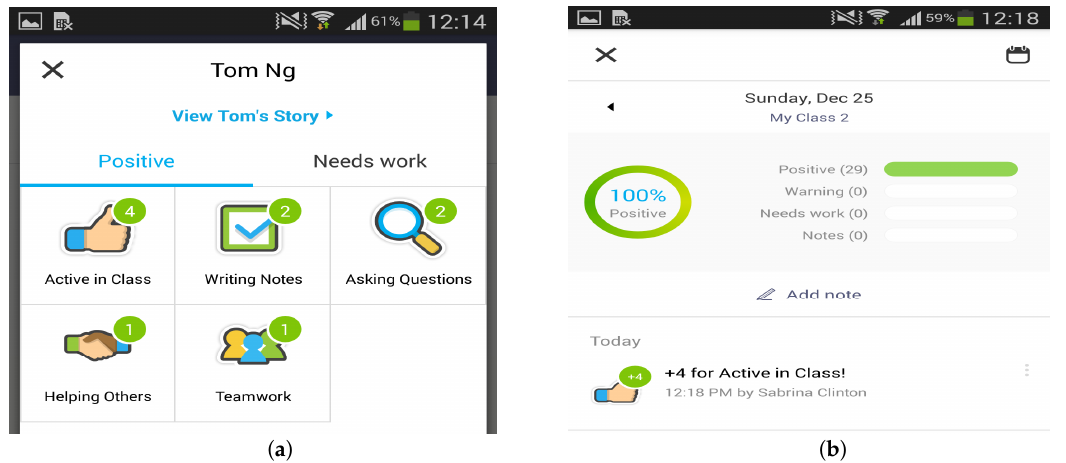
Figure 7. Incentive mechanism of the class engagement analysis (CEA) service. ( a ) Sample report for the teacher; ( b ) Sample report for the